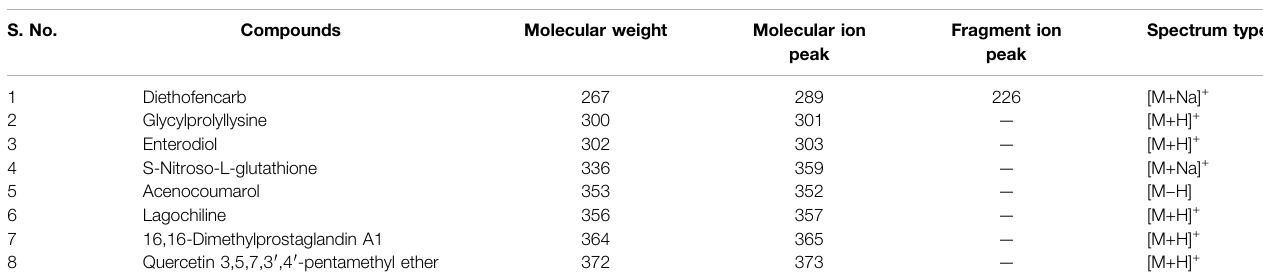
TABLE 2 | Compounds in M.conica identi fi ed by NIST library. S.